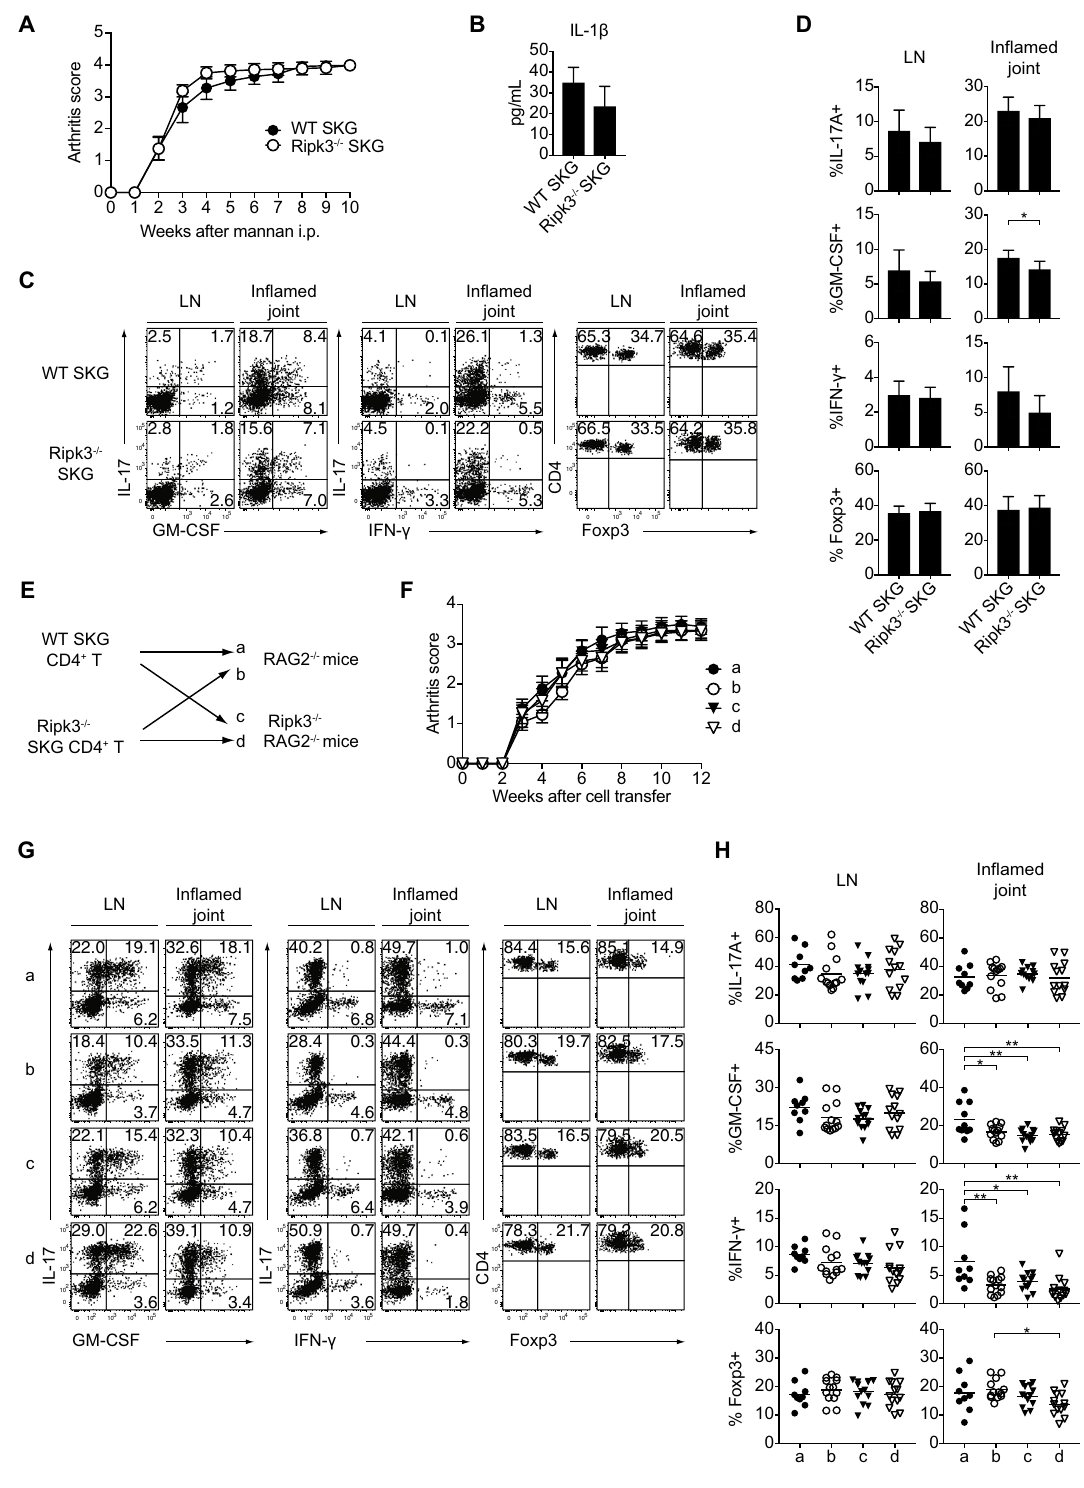
Figure 4. The dispensable role of Ripk3 in the development of autoimmune arthritis . ( A ) Arthritis scores of WT (n = 9) and Ripk3 −/− SKG mice (n = 8) after the injection of mannan (20 mg). ( B ) The IL-1β concentration of synovial tissues from inflamed joints. (C,D) Flow cytometry of IL-17A + , GM-CSF + , IFN-γ + and Foxp3 + cells in CD4 + T cells in draining LNs and the inflamed joints of WT (n = 9) and Ripk3 −/− SKG mice (n = 8) at 10 weeks after mannan injection. (E) Experimental design of the adoptive transfer of CD4 + T cells from WT or Ripk3 −/− SKG mice into Rag2 −/− or Ripk3 −/− Rag2 −/− mice. ( F ) The arthritis scores of the four groups (a–d) shown in ( E ) (n = 9 or 13). ( G , H ) Flow cytometry of IL-17A + , GM-CSF + , IFN-γ + and Foxp3 + cells in CD4 + T cells in draining LNs and inflamed joints of the four groups of mice 12 weeks after cell transfer (n = 9 or 13). The vertical bars denote the SD in panels ( B , D ) and SEM in ( A , F ). The horizontal line in panel ( H) denotes the mean. * P < 0.05, ** P < 0.01. Data are pooled from two independent experiments in panels ( A , B , D , F , H)